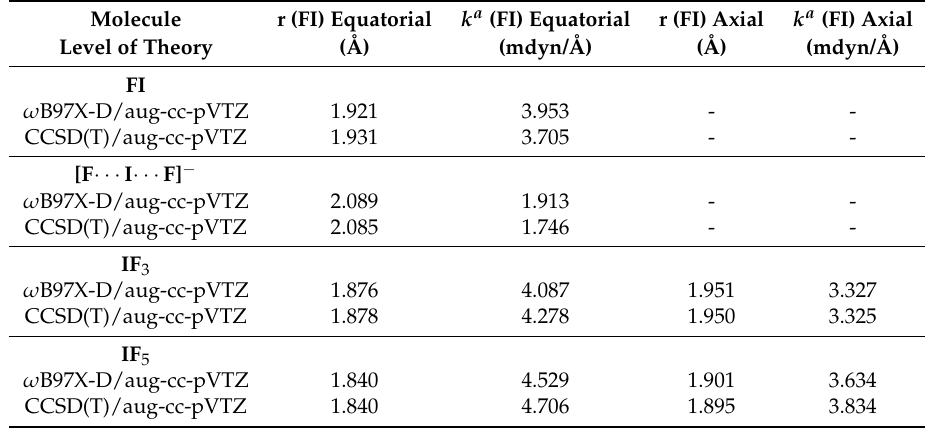
, IF3, and IF5 computed at 2